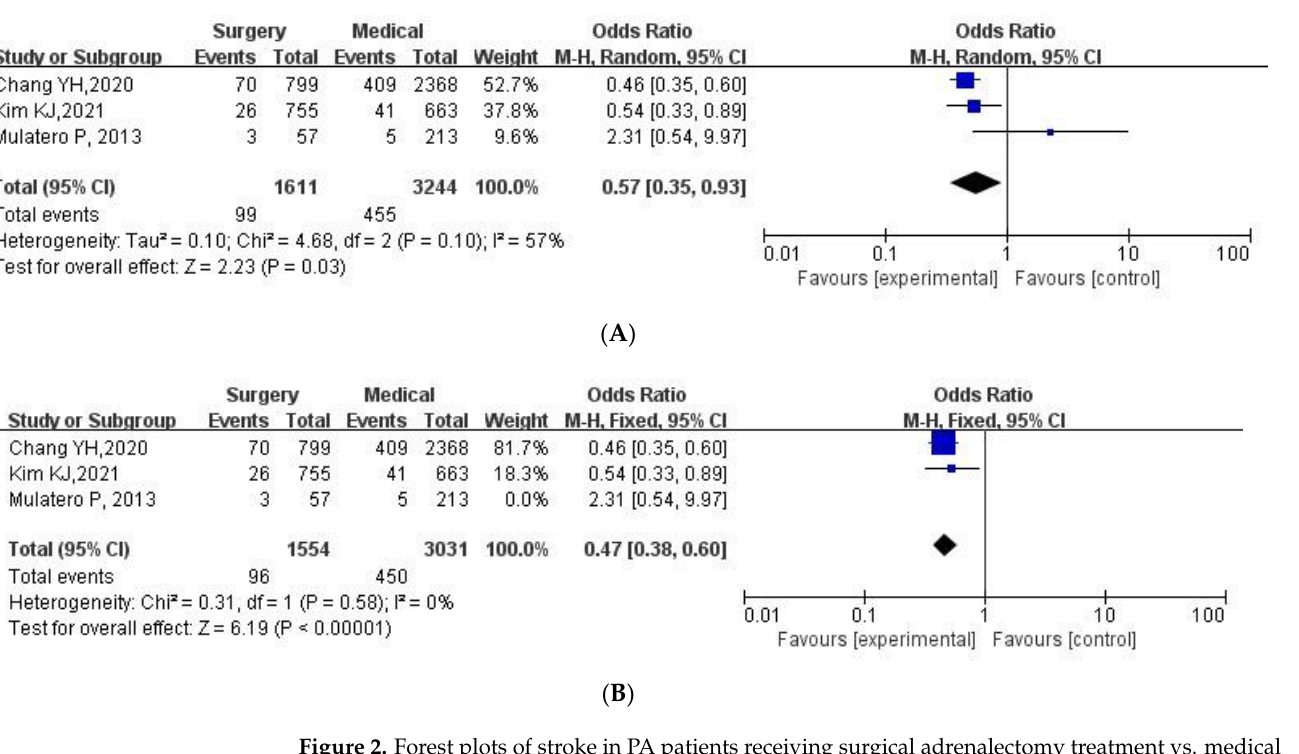
Figure 2. Forest plots of stroke in PA patients receiving surgical adrenalectomy treatment vs. medical treatment. PA, primary aldosteronism. Forest plots for the random effects model ( A ) and fixed effects model ( B ). The blue squares represent the results of individual studies and the black diamonds represent the combined results of total studies in the model.